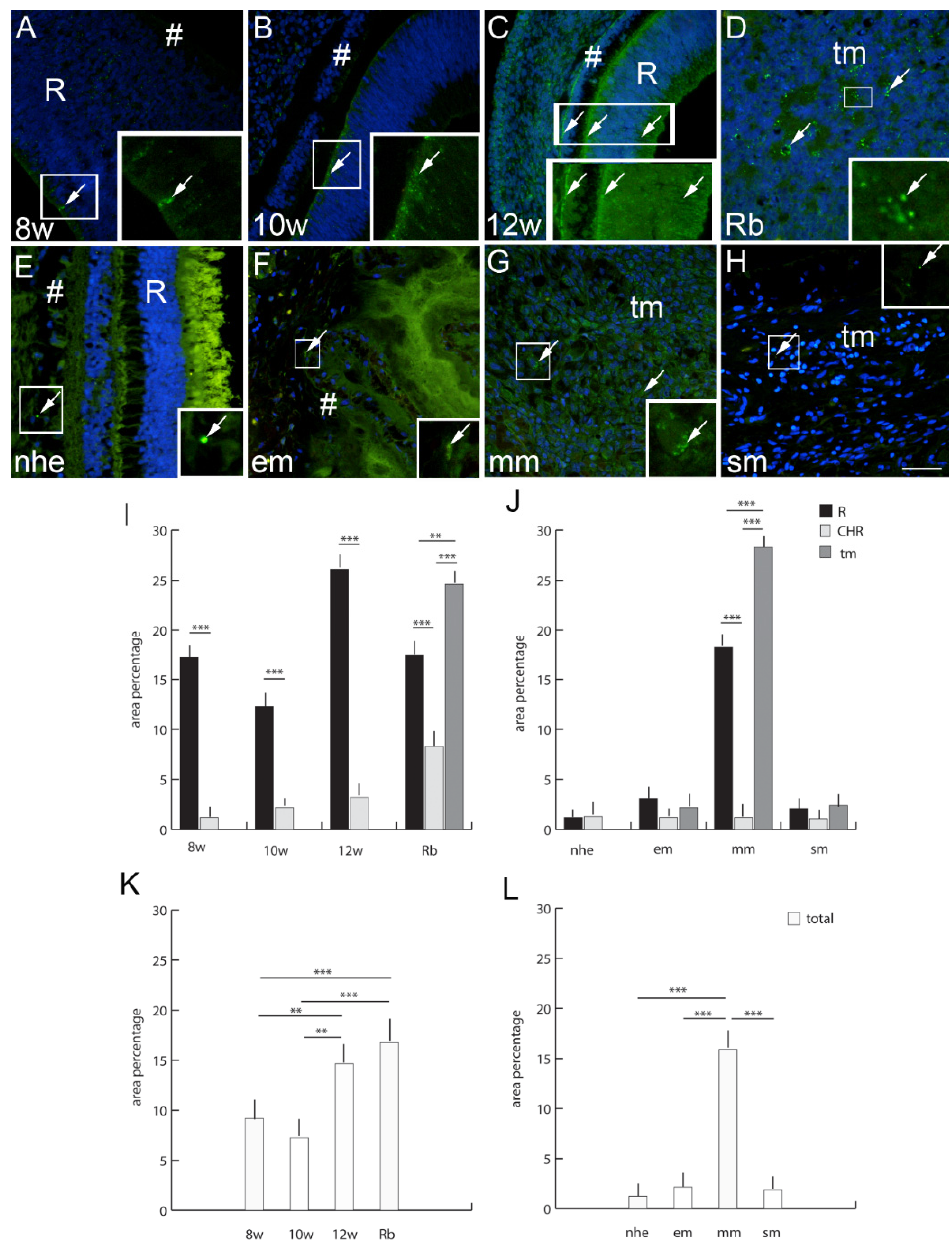
Figure 2. Connexin 37 (Cx37)-positive cells (arrows) can be seen in the eye section of an 8th-week (8 w) ( A ), 10th-week (10 w) ( B ),and 12th week (12 w) ( C ) human embryo, retinoblastoma (Rb) ( D ), normal human eye (nhe) ( E ), epitheloid melanoma (em) ( F ), mixoid melanoma (mm) ( G ) and spindle melanoma (sm) ( H ); R—retina, #—choroidea, tm—tumor tissue. Immunofluorescence staining to Cx37 (green) merged to DAPI (blue nuclei), scale bar 25 μ m. The panel with graphs represents the area percentages of Cx37 in the retina (R), choroid (CHR) and tumor (tm) in the 8th-week (8 w), 10th-week (10 w) and 12th-week (12 w) human embryo, retinoblastoma (Rb), normal human eye (nhe), epitheloid melanoma (em), mixoid melanoma (mm) and spindle melanoma (sm) ( I , J ), and total area percentage of Cx37 ( K , L ). Data are shown as mean ± SD. Significant differences are indicated by ** p < 0.01, and *** p < 0.001. One-way ANOVA followed by Tukey’s multiple comparisons test (comparison between Rb and uveal melanoma types), t -test (comparison between retina and choroid of developmental stages and normal human eye).